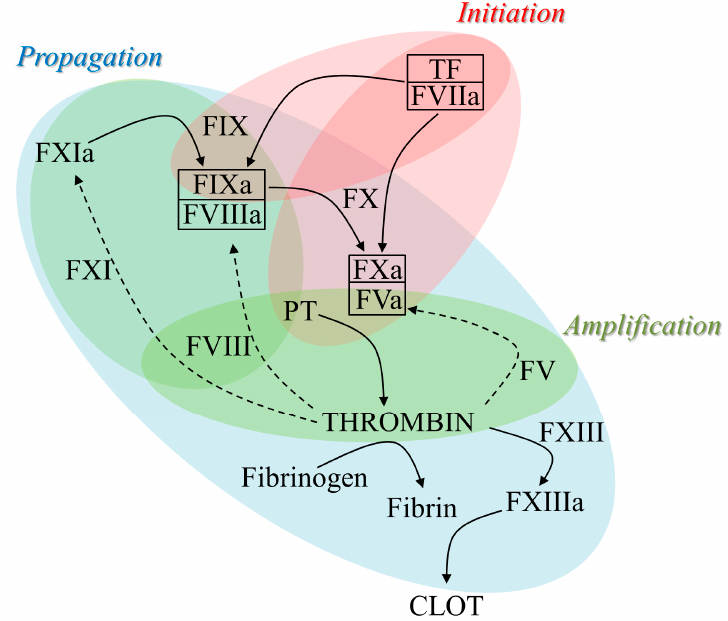
Figure 1. The series of enzymatic reactions in the coagulation cascade. Schematic representation of the coagulation cascade, showing the several direct (black rows) or feedback (dotted rows) reactions that can be subdivided into initiation (red), amplification (green) and propagation (blue) phases, ultimately leading to the fibrin clot. Boxed items indicate the interaction of active enzymes (FVIIa, FXa, FIXa) with their cofactors (TF, FVa, FVIIIa). F, factor; a, activated form; PT, prothrombin; TF, tissue factor.